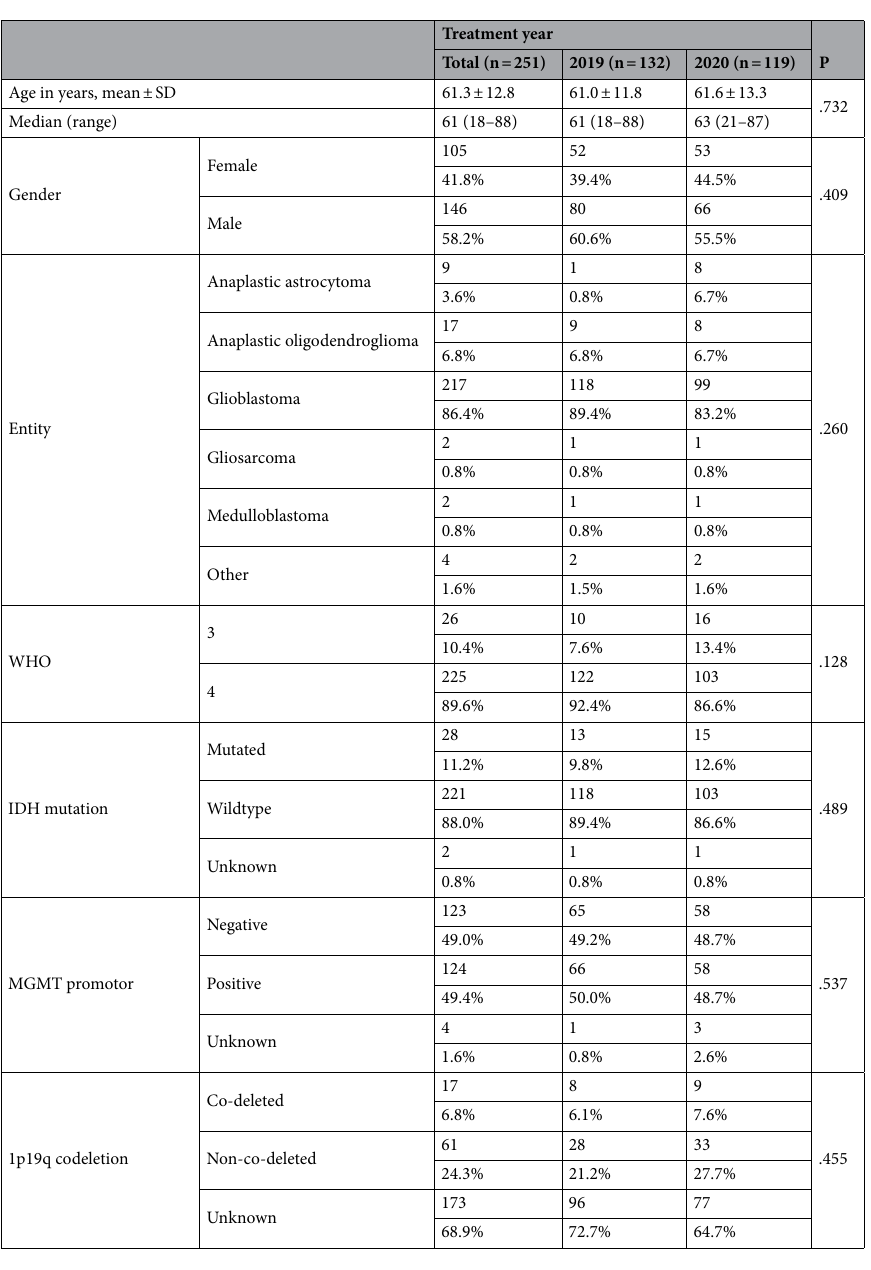
Table 1. Patient Characteristics of the cohorts from 2019 and 2020. WHO—World Health Organization; IDH—isocitrate dehydrogenase; MGMT—O6-Methylguanine-DNA Methyltransferase; KPS—Karnofsky Performance Status Scale. n = number; SD—standard deviation.